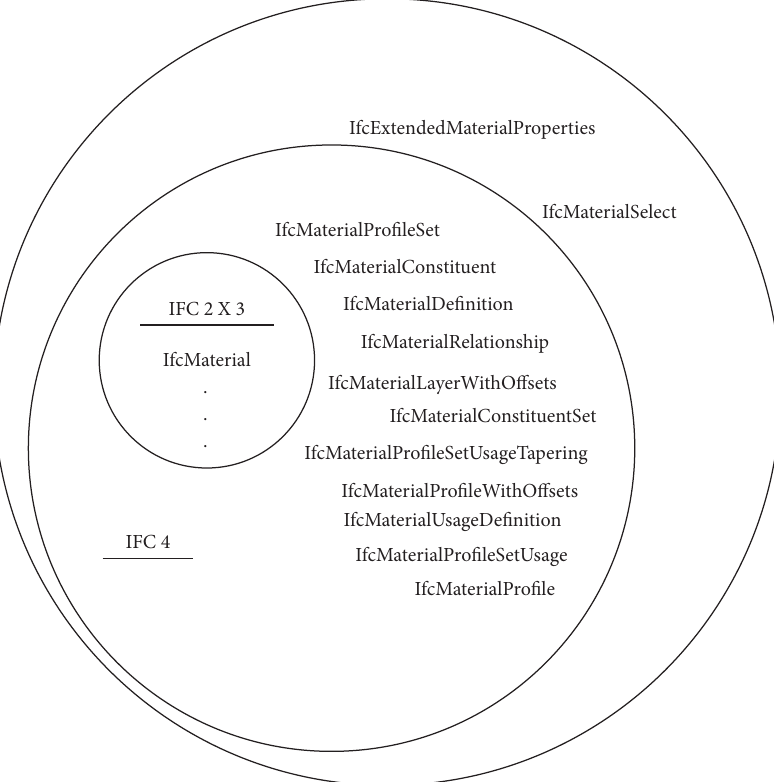
Figure 9: Examples of comparisons of information representation between IFC2X3 and IFC4 MVD